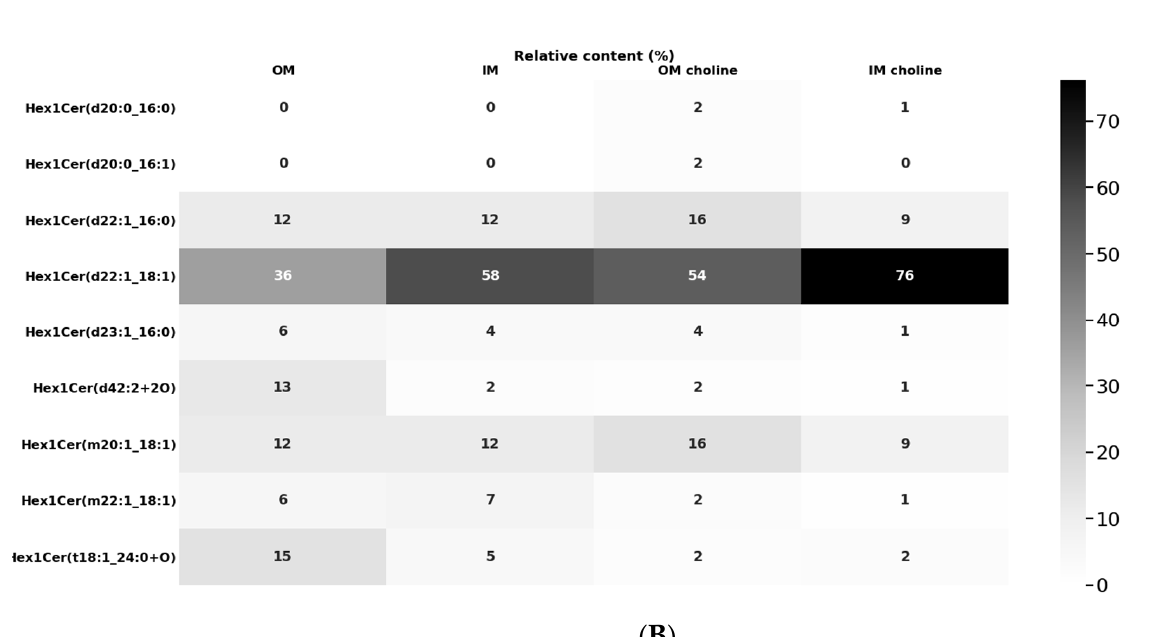
Figure 6. Fragmentation mass spectra in the positive ion mode of Cer(t16:1_12:0) ( A ) and Hex1Cer(d22:1_18:1) ( B ) Abbreviations: NL neutral loss, SPH sphingosine. The position of double bond was not identified in 16:1, 22:1 and 18:1 fatty acids. All ceramides were distributed in the OM and IM, but there were clear quantitative differences for some species between the membranes. Among the total 14 ceramides and oxidized ceramides, one species, cer(16:1_12:0), represented approx. 66% of ceramides in the OM and approx. 44% in the IM in the case of the bacteria cultured without exogenous choline. The content of the cer(t16:1_12:0) (71%) species was higher in the OM, but similar in the IM of bacteria cultured with the addition of choline. Cer(t18:1_12:0) was the second most abundant species, which was localized mainly in the IM (24% or 29% IM choline), while its content in the OM was approx. half, regardless of the bacterial culture conditions (Figure 5A).